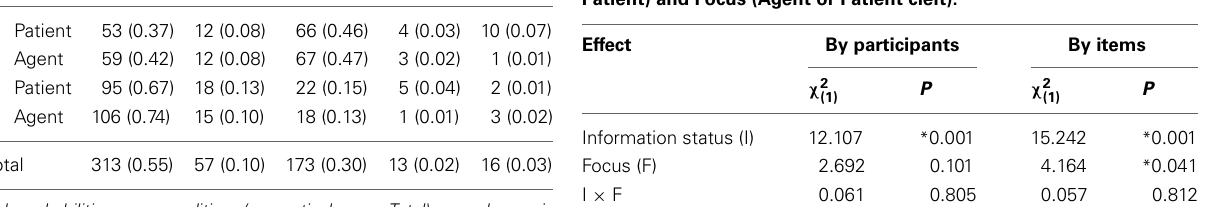
Table 3 | Generalized-Score Chi-Squares from binary logistic GEE analyses, predicting the likelihood of passive-voice responses by factor combinations of Information Status (given Agent or given Patient) and Focus (Agent or Patient